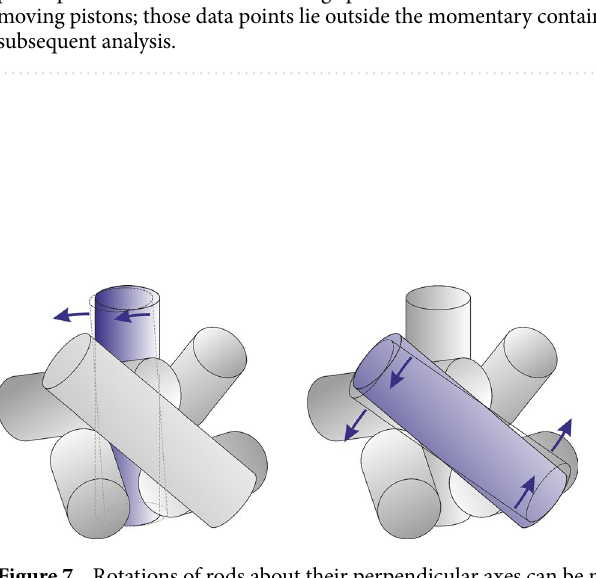
Figure 7. Rotations of rods about their perpendicular axes can be misinterpreted by the evaluation procedure as translational motions, as sketched here. The rod in the background does only rotate, but the detected edge mimics an apparent translational motion to the left. The rotating rod in the foreground has features moving in opposite